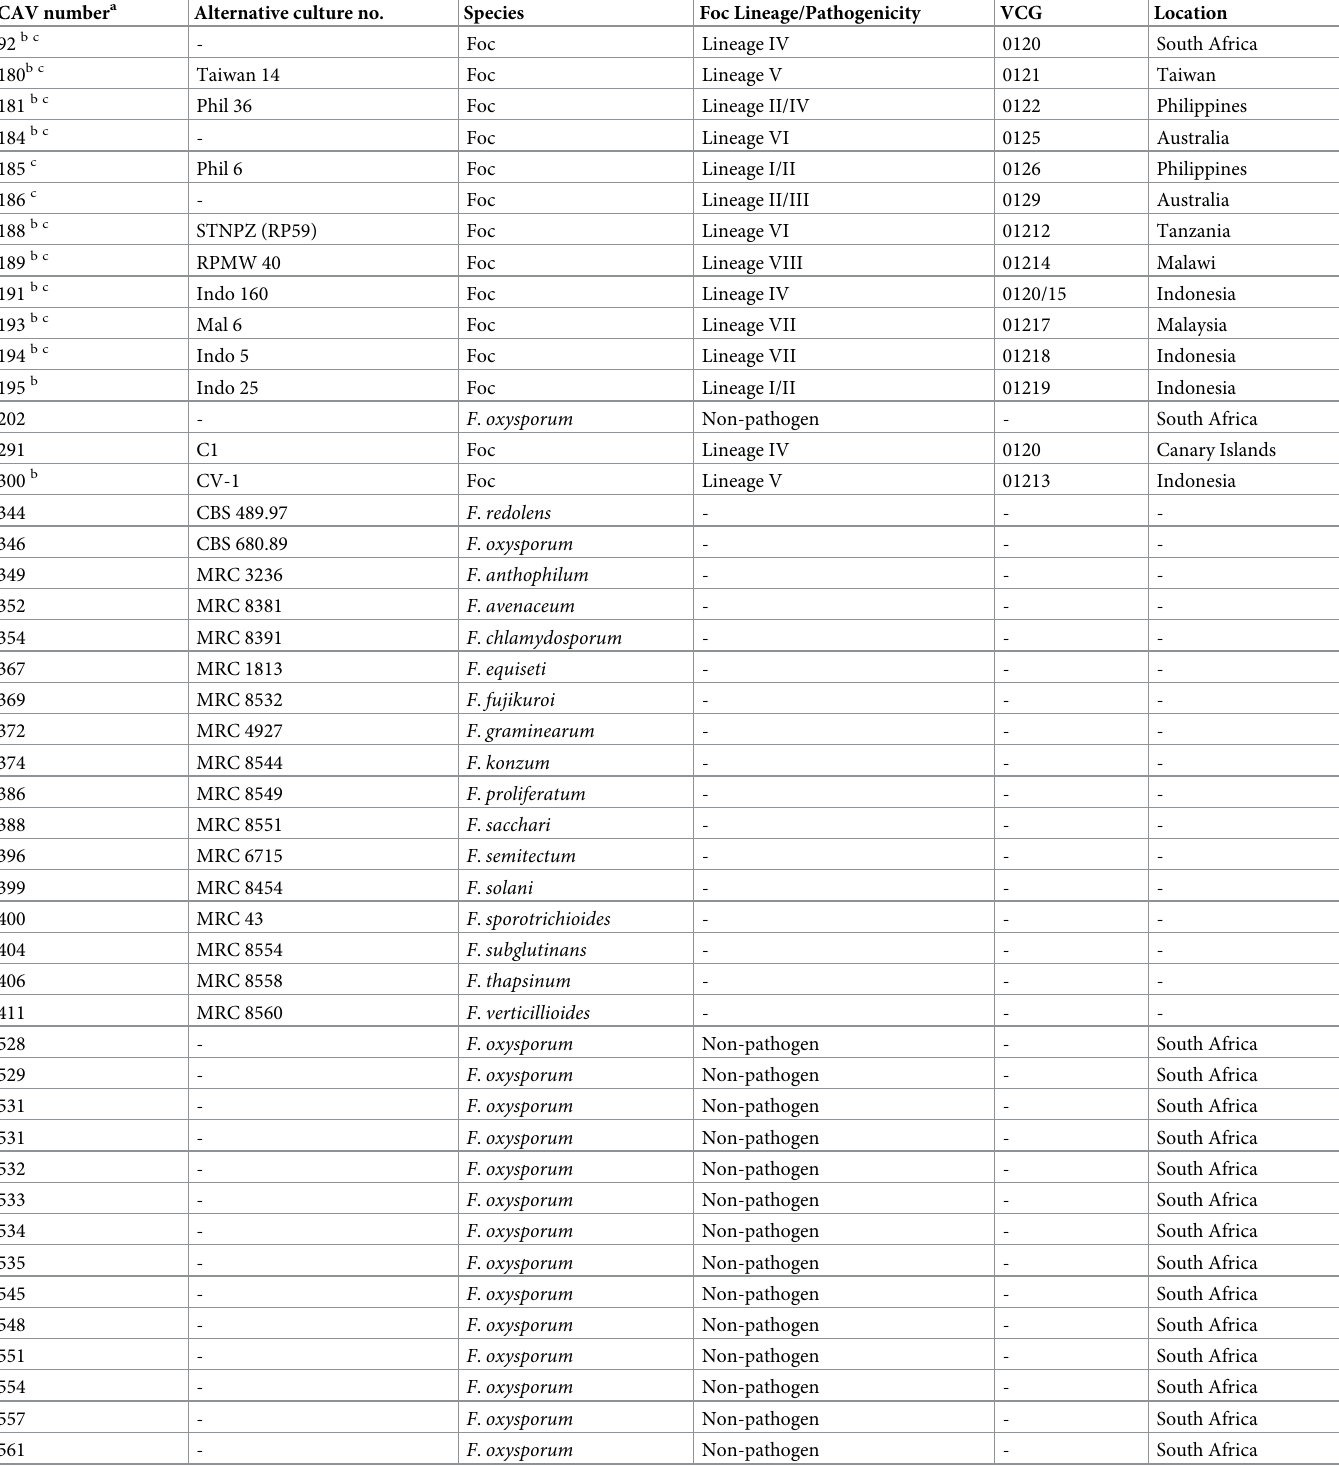
Table 1. Fusarium isolates used to develop quantitative PCR assays for Fusarium oxysporum f. sp. cubense Lineage VI, Tropical Race 4 (TR4) and Subtropical Race 4